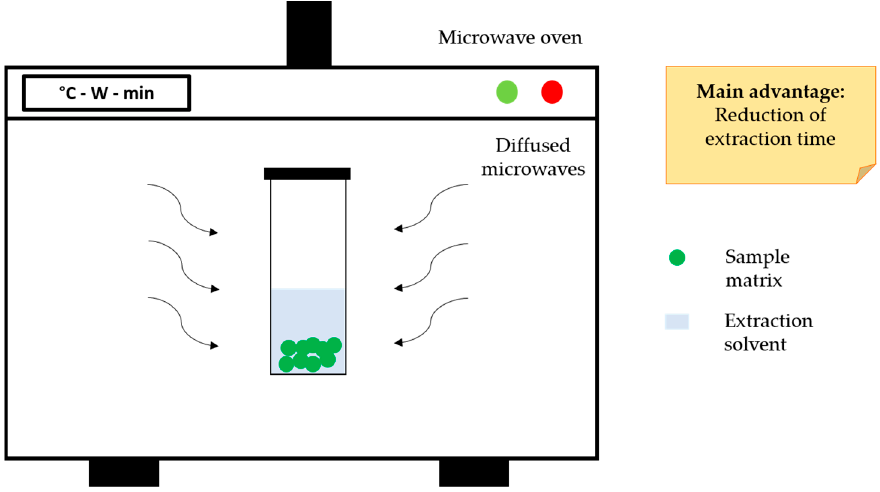
Figure 3. Schematic representation of typical MAE equipment.